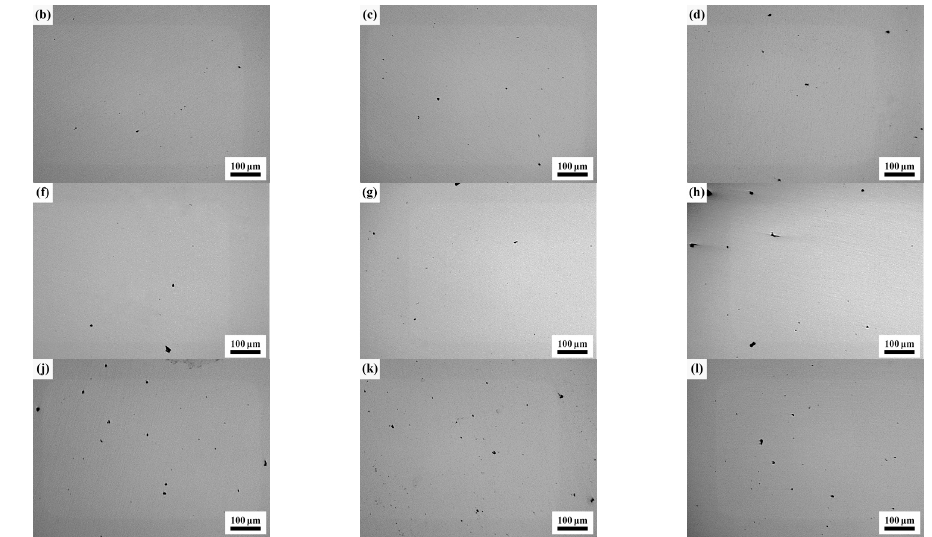
Figure 7. OM images of the Ni3# superalloy after solution heat treatment, ( a ) 1150 °C × 0.5 h, ( b ) 1150 °C × 2 h, ( c ) 1150 °C × 4 h, ( d ) 1150 °C × 8 h, ( e ) 1175 °C × 0.5 h, ( f ) 1175 °C × 2 h, ( g ) 1175 °C × 4 h, ( h ) 1175 °C × 8 h, ( i ) 1200 °C × 0.5 h, ( j ) 1200 °C × 2 h, ( k ) 1200 °C × 4 h, and ( l ) 1200 °C × 8 h. Table 2. The sizes and shape factors of the TIPs of the as-HIPed specimens and the specimens after high-temperature solution heat